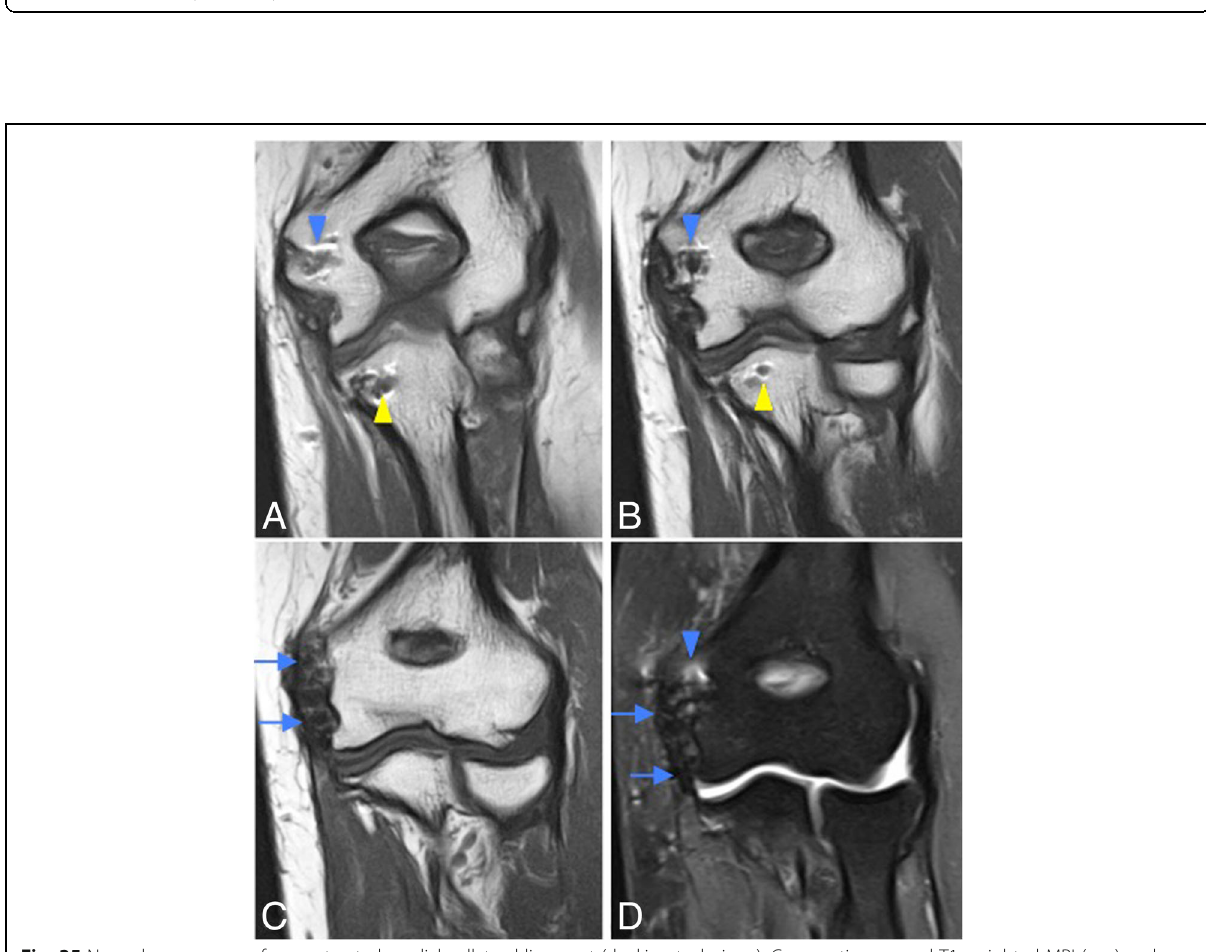
Fig. 35 Normal appearance of reconstructed medial collateral ligament (docking technique). Consecutive coronal T1-weighted MRI ( a – c ) and coronal FS PD-weighted MRI ( d ). The intact graft (blue arrows) extends from humeral tunnel (blue arrowheads) to ulnar tunnel (yellow